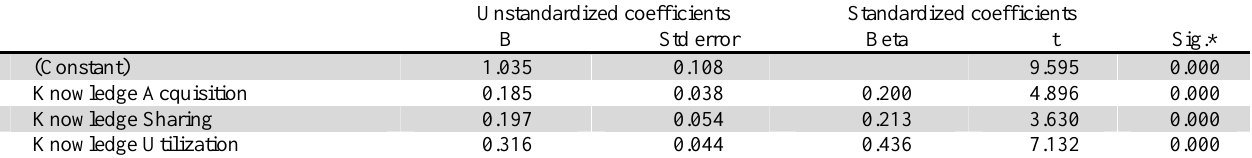
Regression equation- Embedded Systems and knowledge management Unstandardized coefficients Standardized coefficients